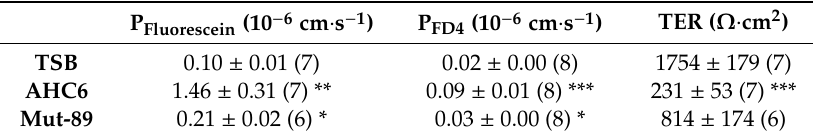
Table 1. Measurements of permeability to fluorescein (332 Da, P Fluorescein ) or FITC-dextran 4000 (4 kDa, P FD4 ) and corresponding transepithelial resistance (TER) (mean ± SEM ( n ), * p < 0.05; ** p < 0.01; *** p < 0.001).